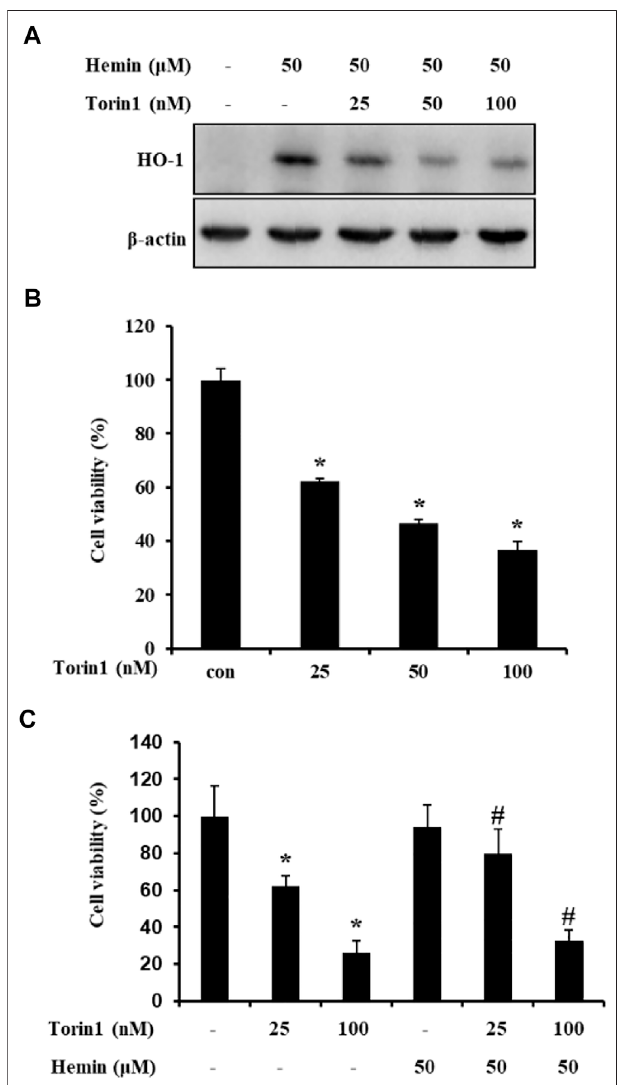
FIGURE 3 | Torin1 inhibition of HO-1 expression in colorectal cancer SW480 cells. (A) . After pretreatment with hemin for 2 h, SW480 cells were treatedwithdifferentconcentrationsofTorin1for48 h.Wholecelllysateswere prepared,and HO-1 wasdetectedusingWesternblotanalysiswithanti- HO-1. (B) . SW480 cells were treated with Torin1 for 48 h. (C) After pretreatment with hemin and Torin1 for 2 h, cells were treated with brazilin for 48 h. Cell viability was measured using the MTT assay. Results shown are mean±SDofthreeindependentexperiments. The p -valuesdeterminedusing Student ’ s t-test were * p < 0.05 compared with cells treated only with torin1. # p < 0.05 vs. compared with cell treated with hemin only. The experiments were repeated for at least of three